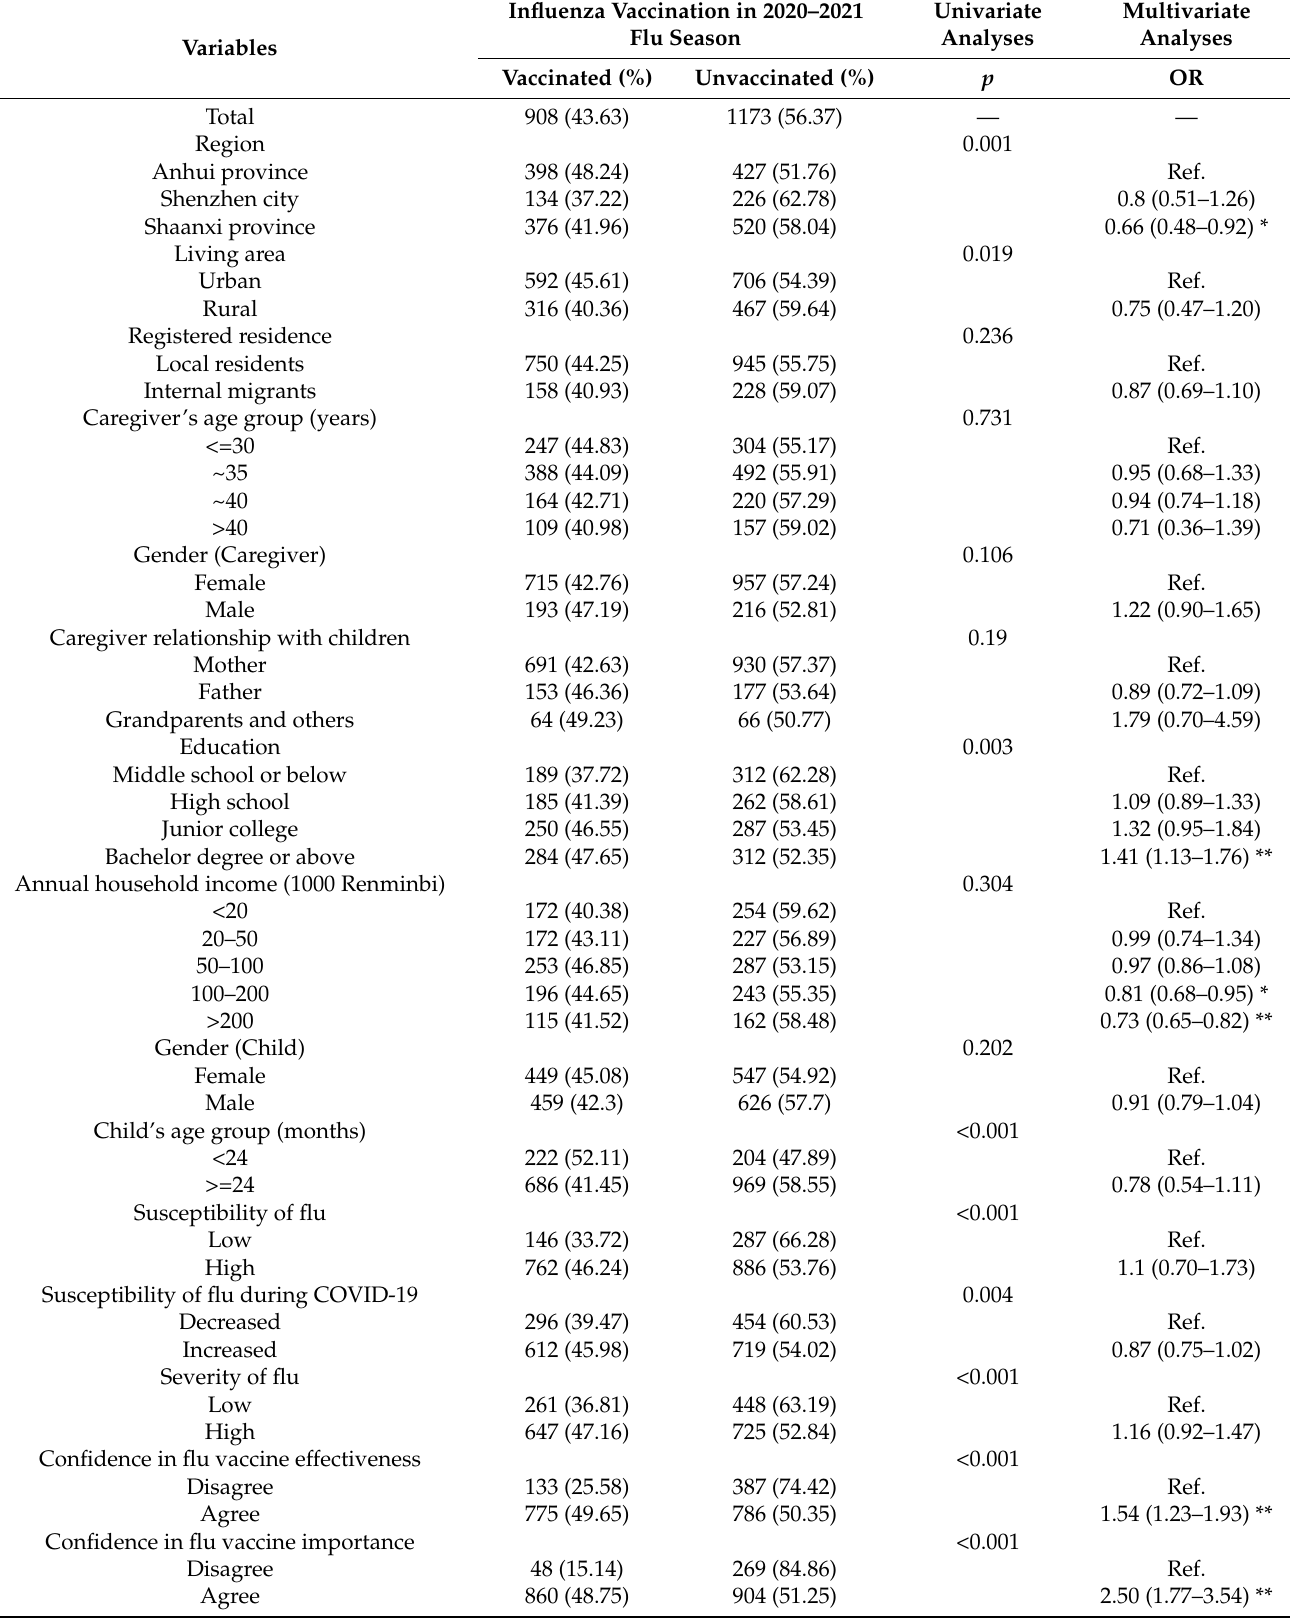
Table 1. Determinants of childhood influenza